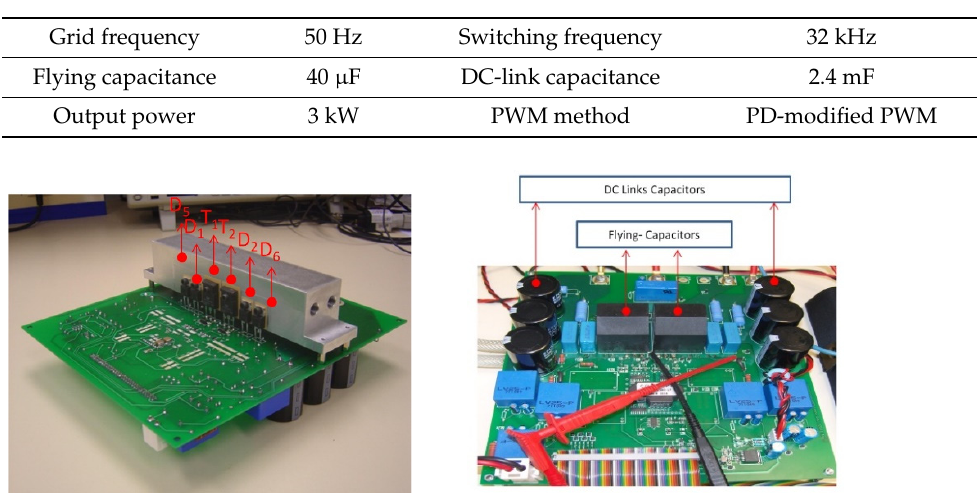
Figure 16. Experiment system of the five-level VIENNA active rectifier.